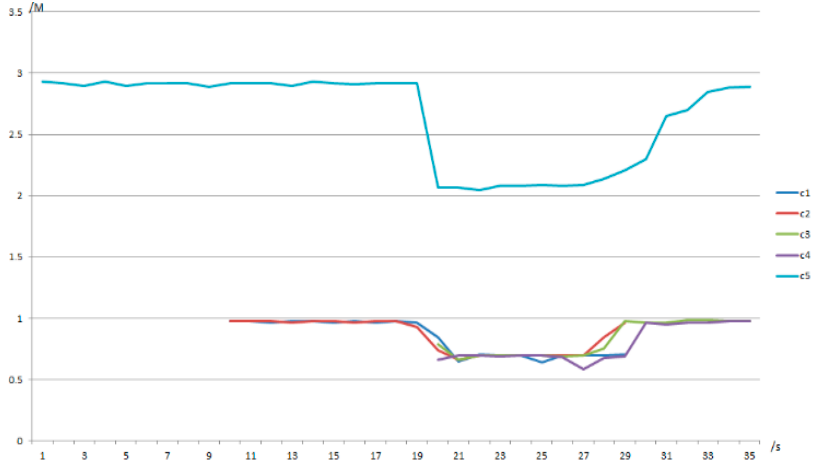
Figure 6. Real-time bandwidth without congestion control queues.